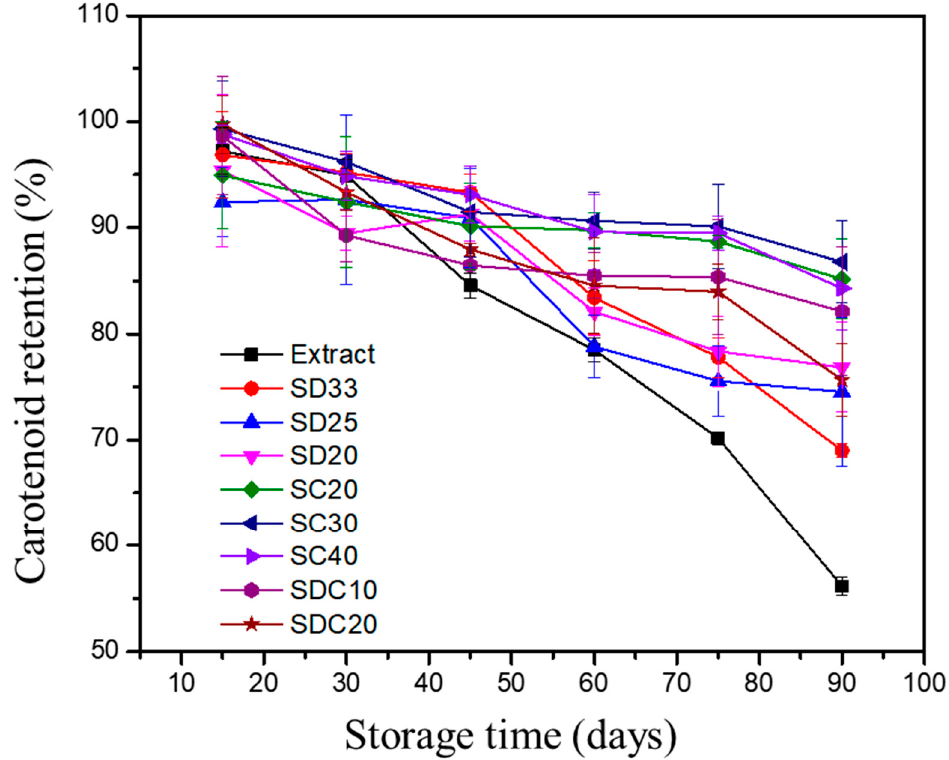
Figure 2. Carotenoid retention (CR, %) in nonencapsulated extracts and microparticles obtained by spray drying, chilling, and their combination, during 90 days of storage at 25 ◦ C. SD: microparticles obtained by spray drying; SC: microparticles obtained by spray chilling; SDC: microparticles obtained by spray drying and chilling combination. The numerical suffix denotes the proportion of core/carrier material of each formulation.